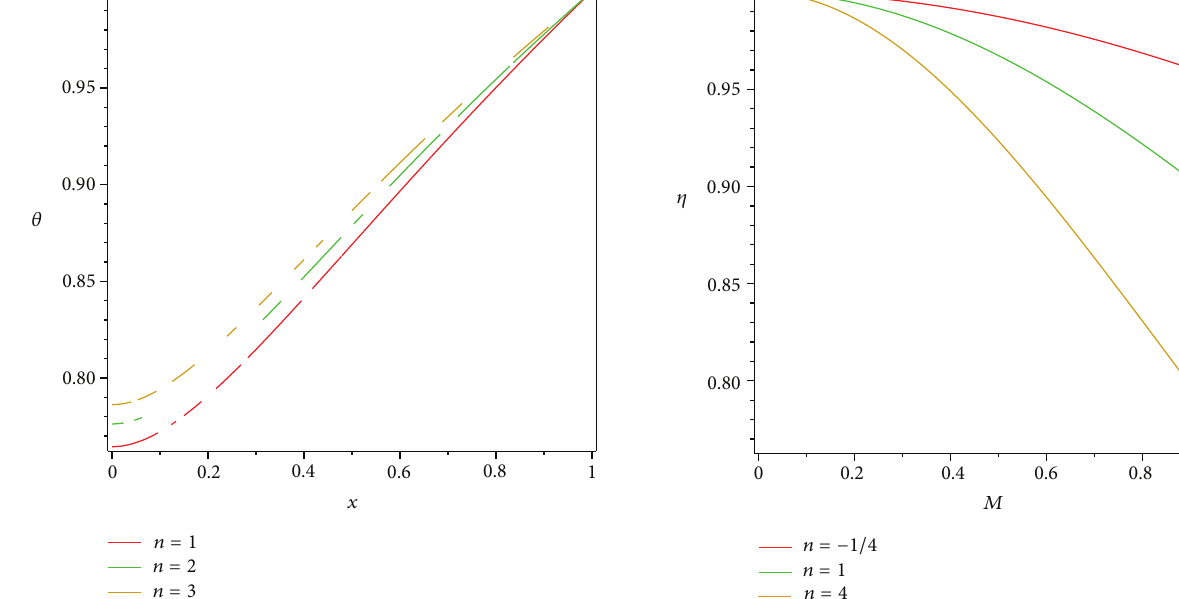
Figure 6: Temperature distribution of a fin profile 𝑓(𝑥) = (𝑥 + 1) 3 as given in solution (22) in a fin with varying values of 𝑛 . Here, the thermogeometric fin parameter is fixed at 1.58 .